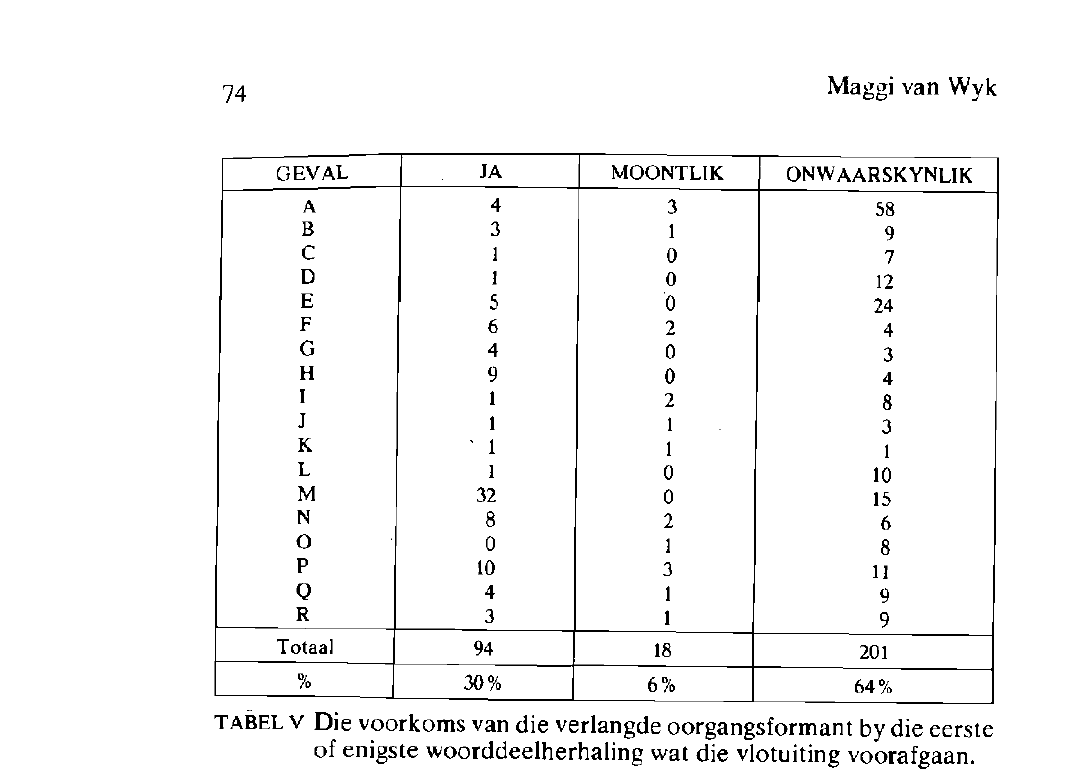
TABEL V Die voorkoms van die verlangde oorgangsformant by die eerste of enigste woorddeelherhaling wat die vlotuiting